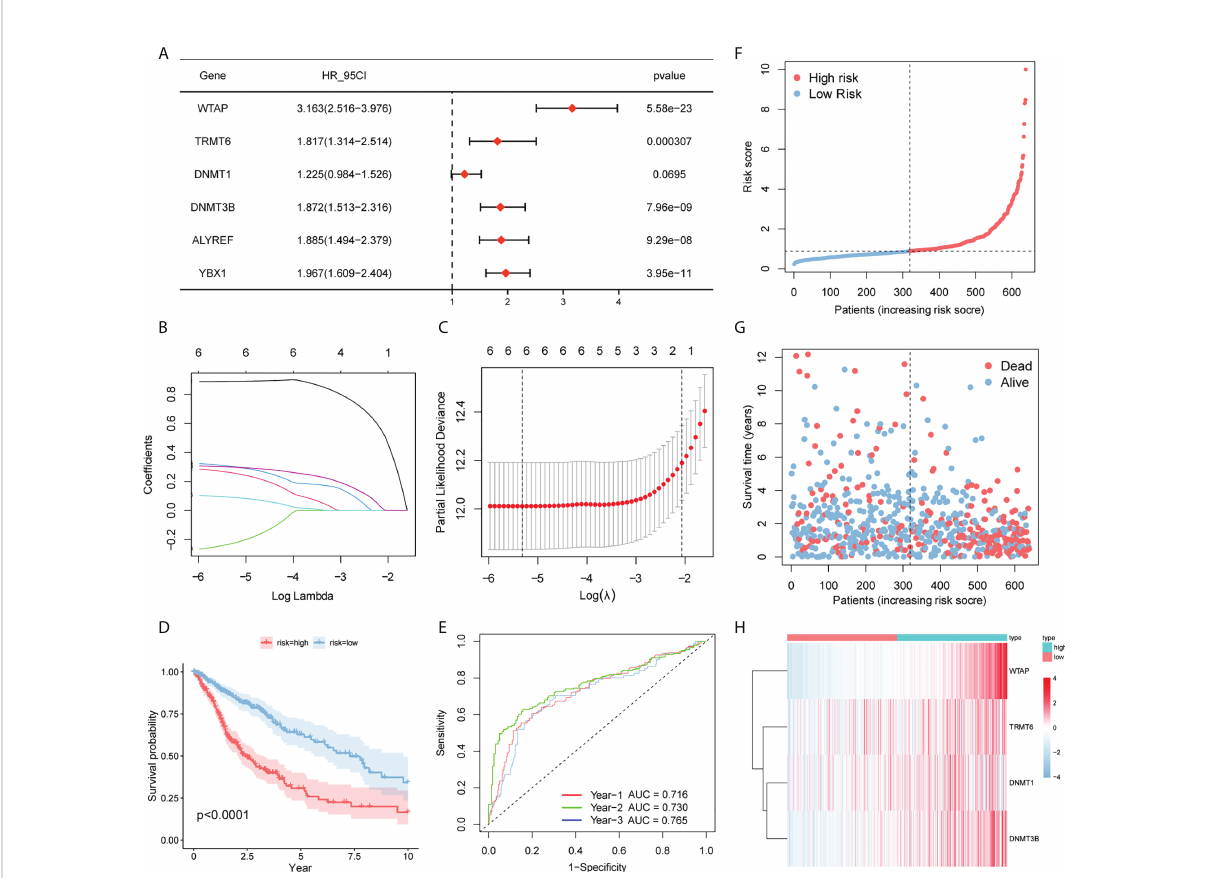
FIGURE 6 Prognostic model. (A) Screening of genes with P <0.1 by univariate Cox regression analysis. (BC) Lasso – Cox regression to screen the related genes of m 6 A/m 5 C/m 1 A. (D) Survival curves of high- and low-risk groups in TCGA. (E) Time-dependent ROC curve for prognosis based on risk score. (F – H) Risk trigram showing risk distribution of patients and expression of key genes in different subgroups.